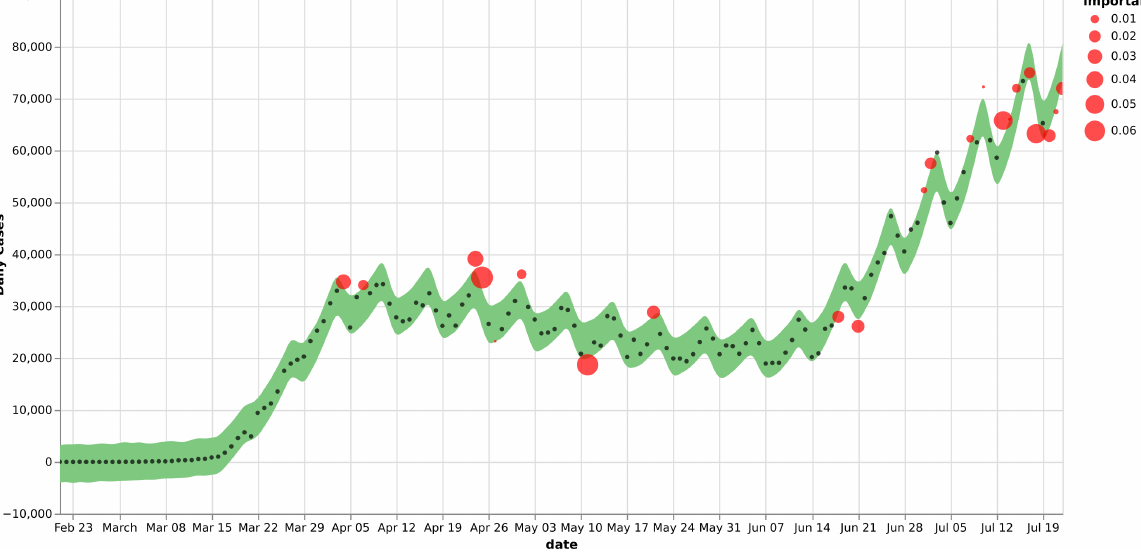
Figure 10. The confirmed cases reported in the USA (black dots), line with an 80% confidence interval (green band), and the importance of outliers is annotated based on how far the dot is from the boundary of the confidence